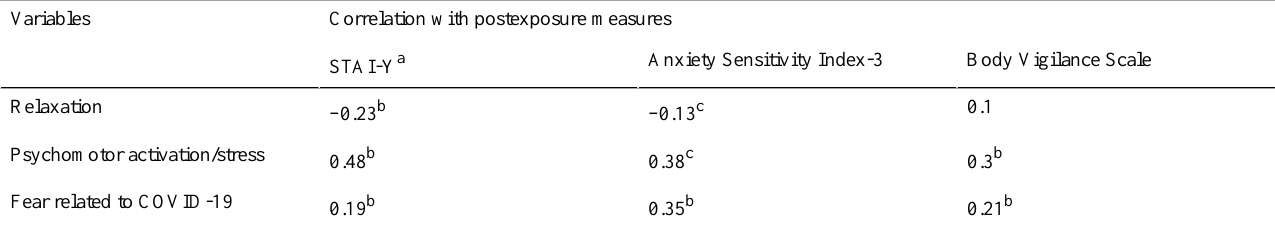
Table 3. Descriptive statistics of the correlations between total scores. Correlation with postexposure measuresVariables